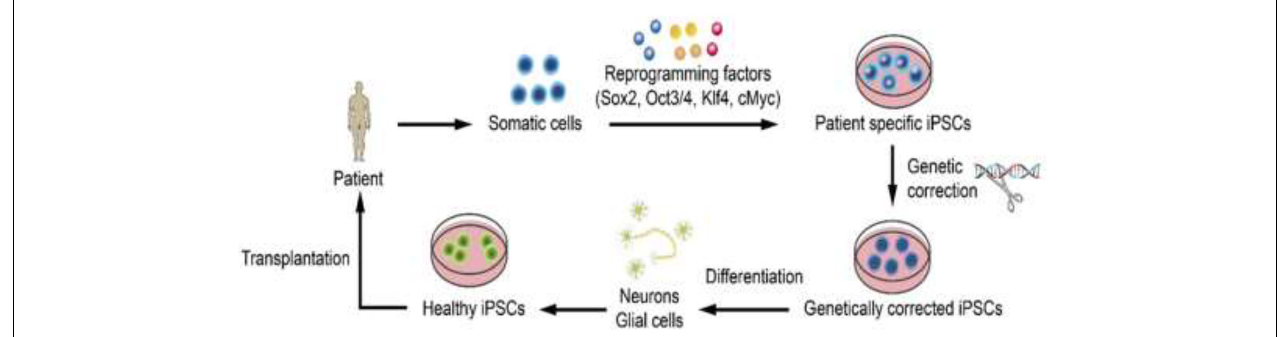
FIGURE 2 | Steps of iPSC-based therapy. First, somatic cells are collected from the patient. Next, somatic cells are reprogrammed into iPSCs by the introduction of reprogramming factors. Thereafter, genetically corrected iPSCs are generated by genome editing. The corrected iPSCs differentiate into neurons or glial cells. Healthy iPSCs are obtained via quality assessments. Finally, cell therapy can be achieved by transplanting the cells into a patient with ischemic stroke (Alessandrini et al., 2019; Farkhondeh et al., 2019; Yasuhara et al.,